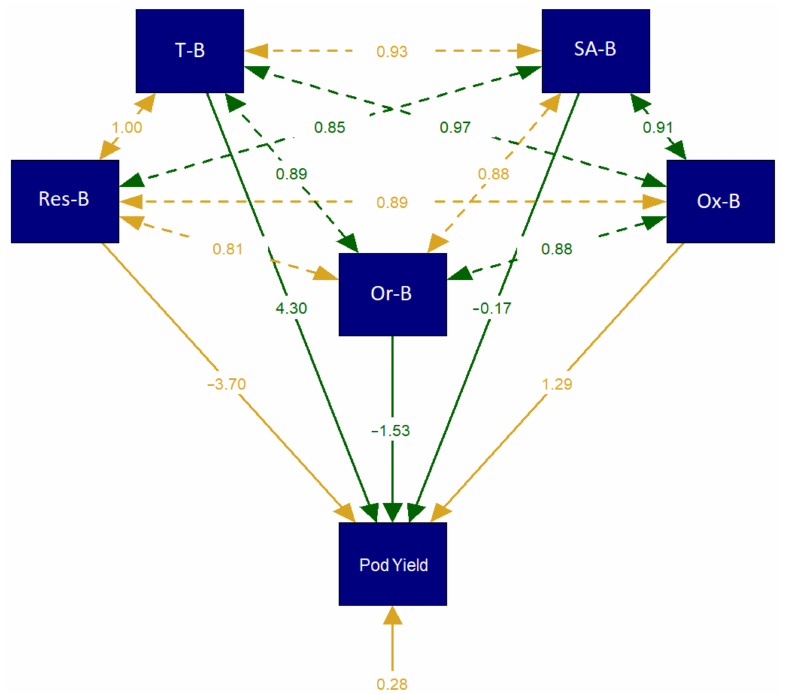
Figure 5. Path diagram and coefficient of factors of different B fraction influencing pod yield of groundnut. Single head arrows and connector indicate direct effect and natural association, respectively.